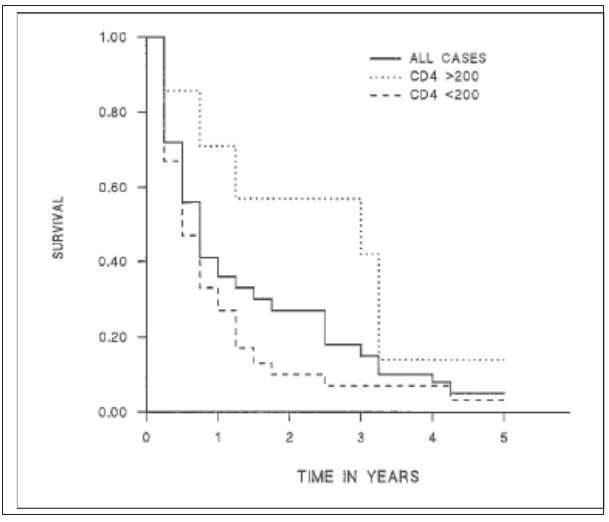
Figure 1) Life table analysis for 37 cases. Patients with a CD4 count <200 x 10 6 /L had reduced survival (P<0.03). CD4 counts were